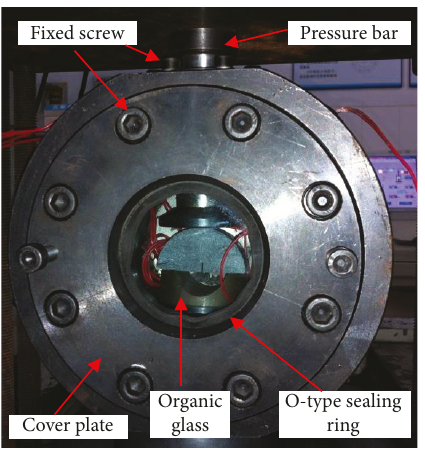
Figure 3: Gas-sealing device.